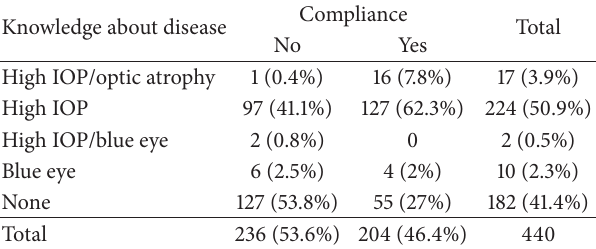
Table 3: Effect of basic knowledge of glaucoma disease on compli- ance to antiglaucoma